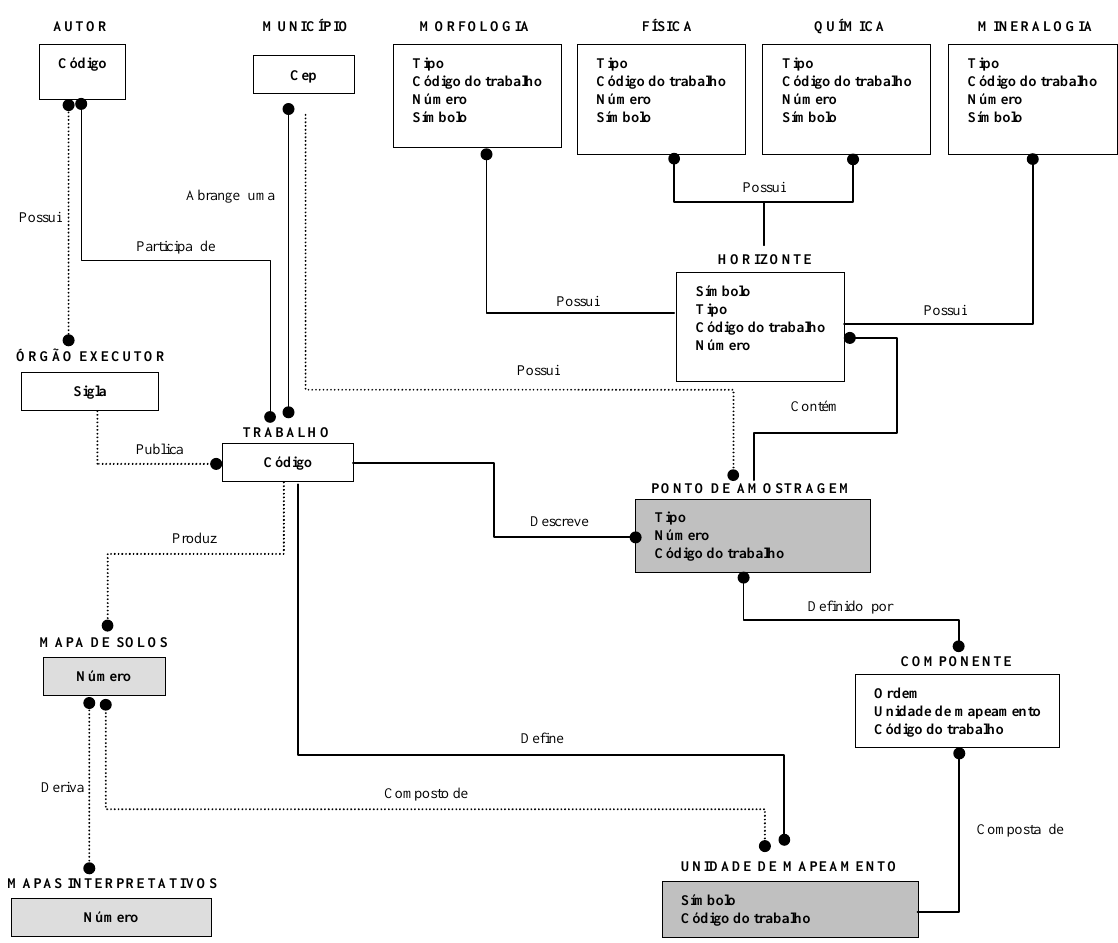
Figura 2. Modelo conceitual simplificado do